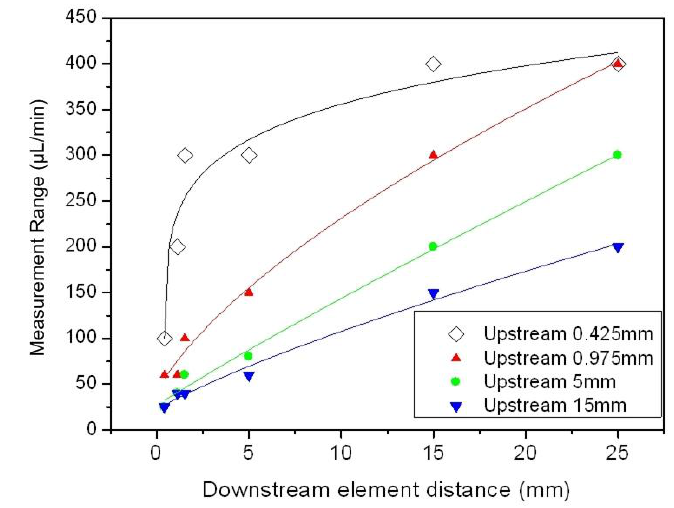
Figure 10 . The measurement range as a function of the downstream element distance. The data are extracted form Frame 1 (water as the test fluid). Each facet is represented by a different color as indicated in the